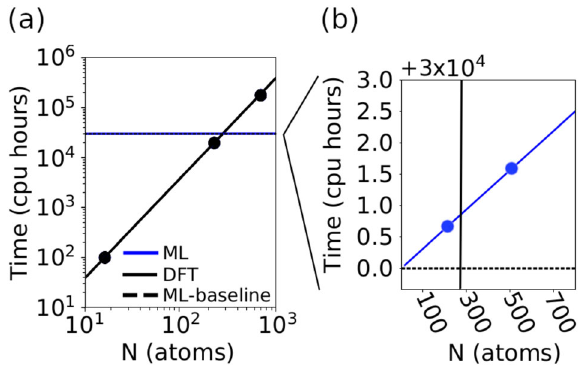
Fig. 7 Comparison between computational costs of DFT and ETI approaches. a DFT calculations scale quadratically with system size (solid black line). b Feature extraction scales linearly with system size (solid blue line). Black dashed line in both plots represents time to acquire DFT training